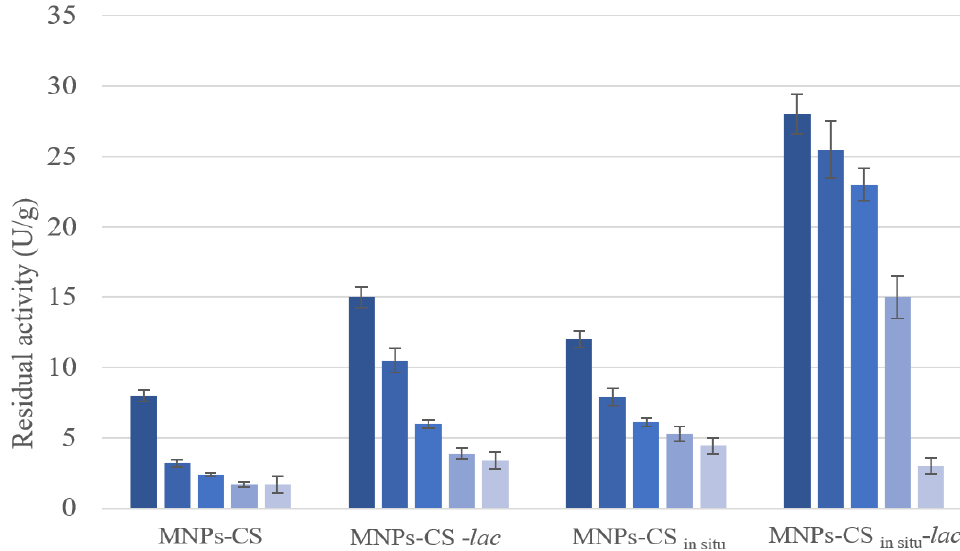
Figure 7. Reuse cycles in the oxidation reaction of ABTS by the magnetic systems without and containing immobilized laccase.